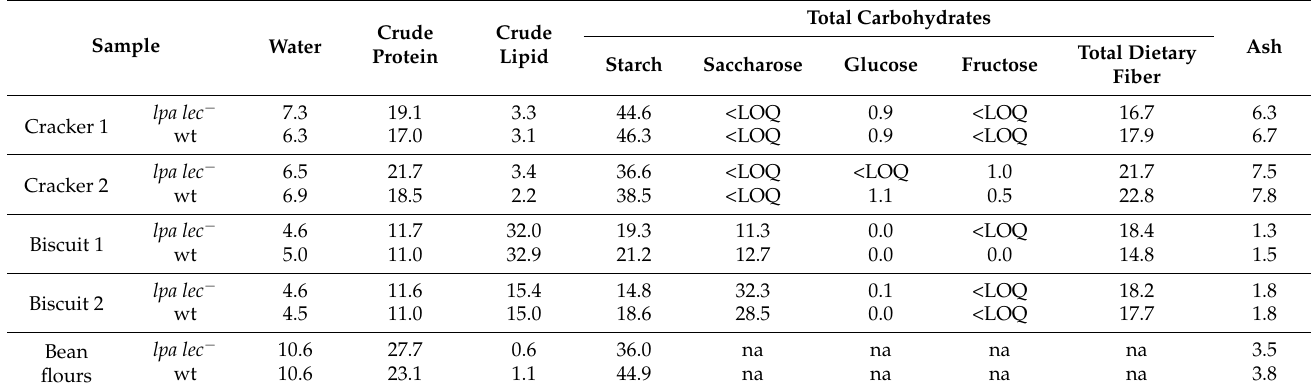
Table 3. Proximate composition of bean-based products (g/100 g dry matter). na, non-analyzed; <LOQ, under limit of